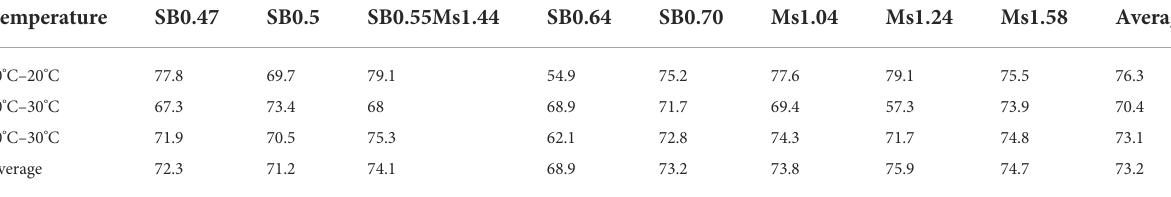
TABLE 4 Activation energies E a expressed in kJ/mol for each composition (method of superposition).